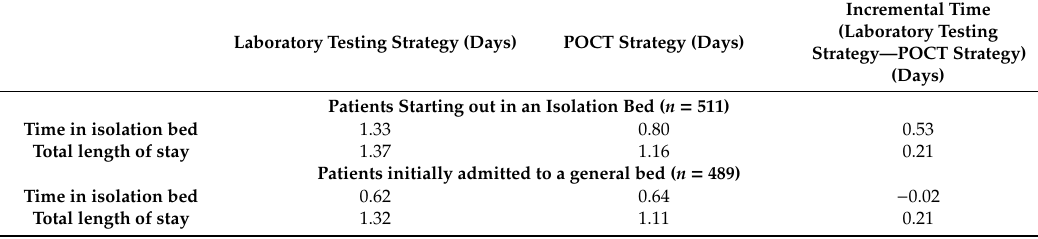
Table 1. Time analysis of laboratory testing and point of care test (POCT) strategies for a cohort of 1000 hospitalized patients with suspected infectious diarrhea. The results presented are an average, per patient value for isolated and non-isolated patients. Standard deviations are presented in brackets.